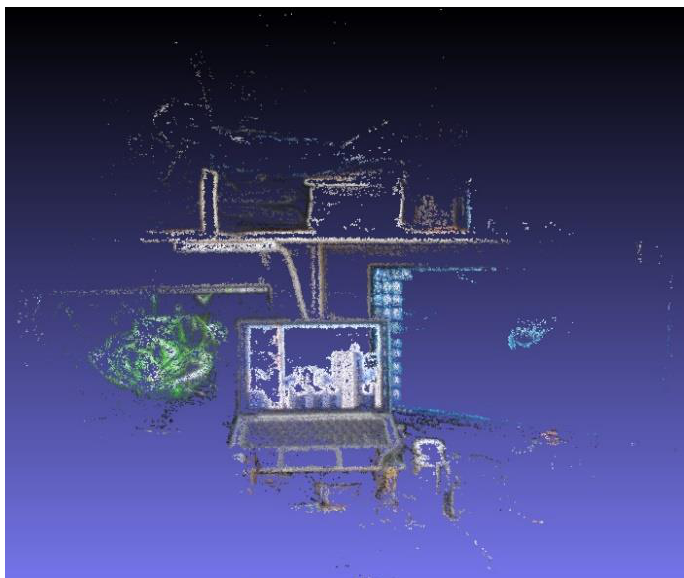
Figure 15. Three-dimensional reconstruction results of images shot by the compound-eye system.